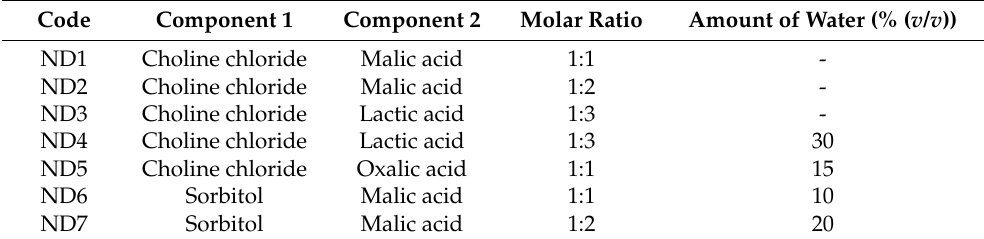
Table 2. Composition of NADES